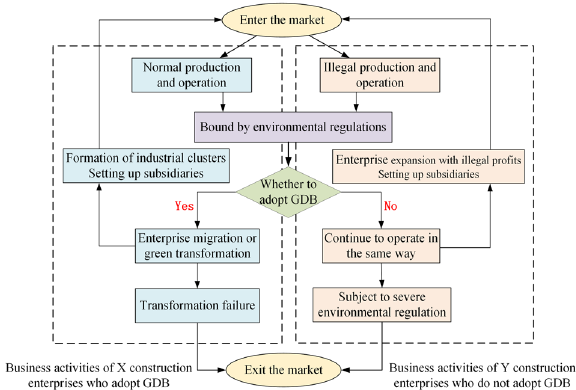
Fig. 2 Simulation fl ow design diagram of agent-based modeling. It shows the operation process of construction enterprises adopting GDB and those not adopting GDB in the simulation model through dotted boxes. The solid arrows represent the general operation process of enterprises. Note: GDB means green development